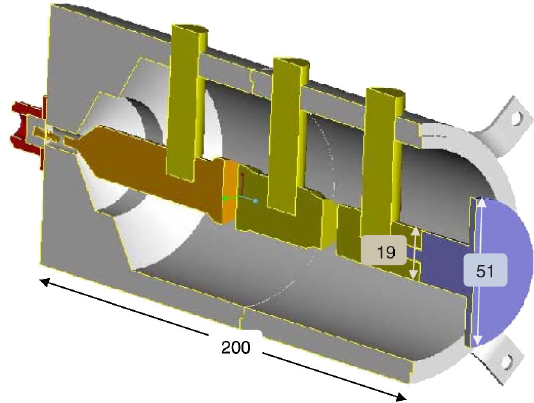
FIG. 23. Sketch of a capacitive HOM damper with a high-pass filter attached (dimensions in mm).